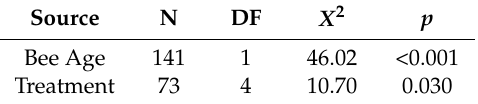
Table 3. Results from statistical tests of pesticide treatments on honey bee respiration after two weeks.